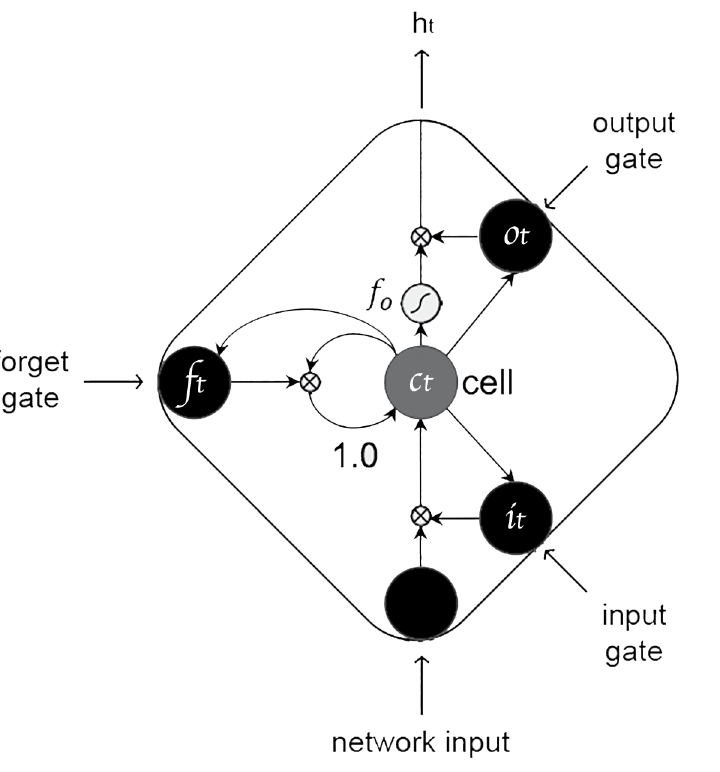
Fig 1. LSTM memory